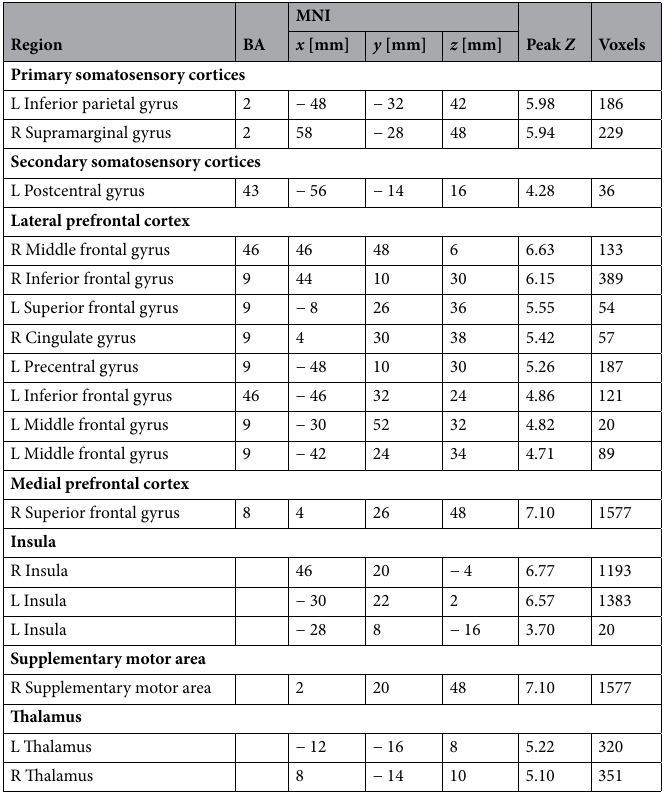
Table 7. MNI coordinates of the activated clusters in trial 7. In this trial, a stimulation current amplitude that was 1.5 times that of the standard amplitude was applied. Threshold values of uncorrected p and cluster extent k were set as smaller than 0.001 and more than 20, respectively. L left hemisphere; R right